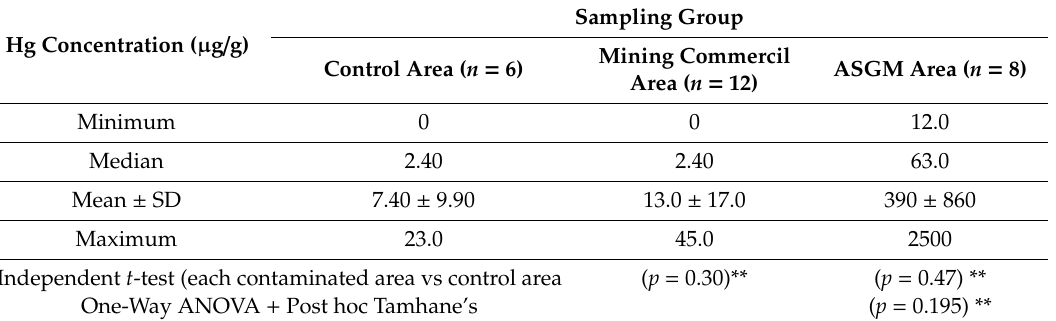
Table 1. Distribution of soil sample based on the minimum, median, mean, standard deviation, and maximum mercury (Hg)